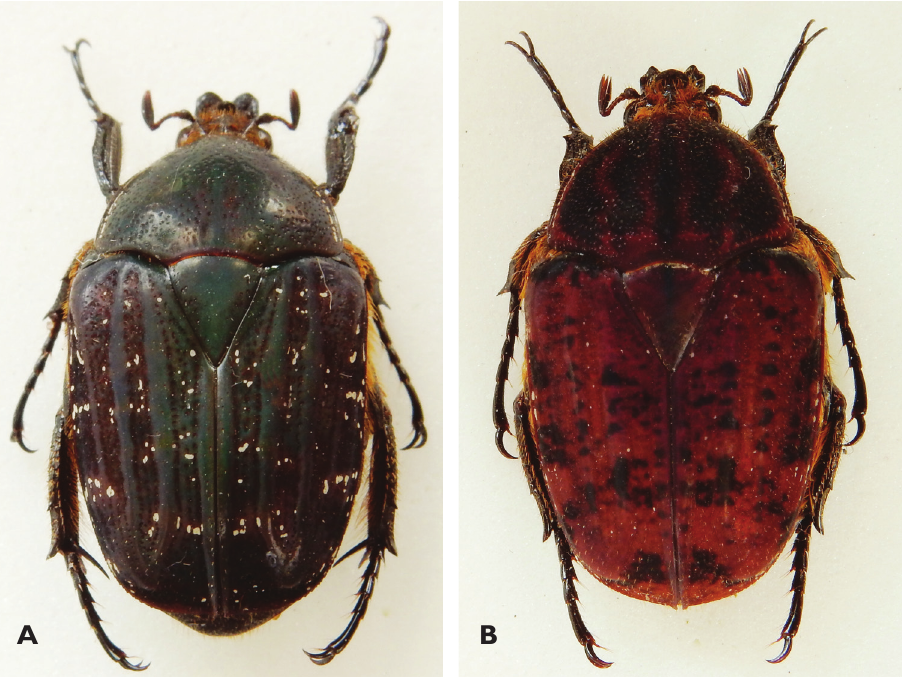
Figure 1. Dorsal habitus of A Lamellothyrea descarpentriesi (Marracuene, Mozambique) and B Lamel- lothyrea isimangaliso sp. n. (St Lucia, South